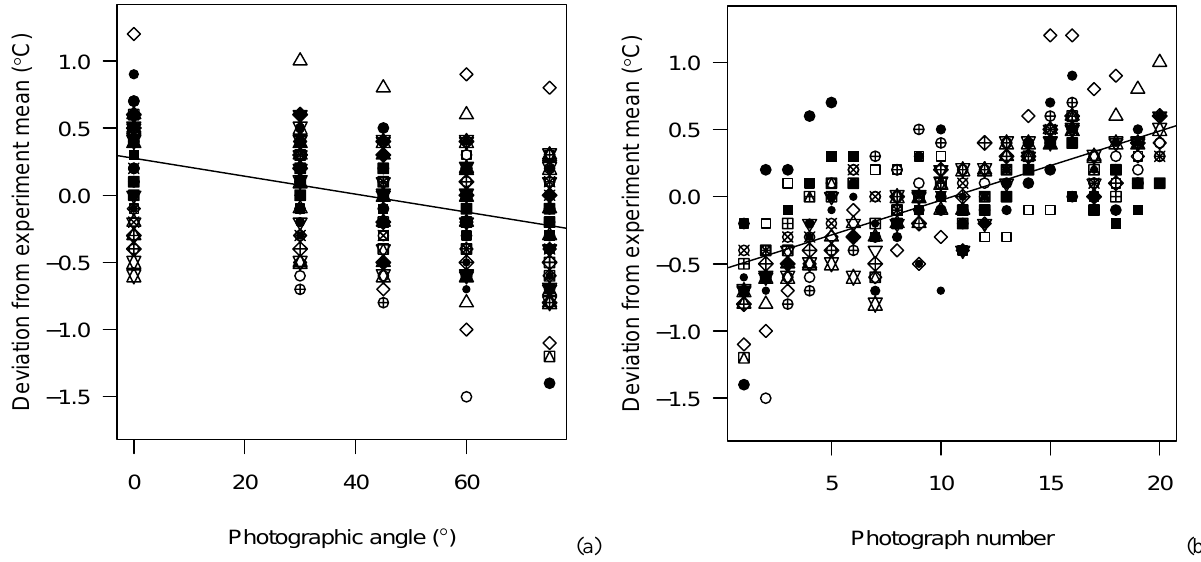
Fig. 4. (a) Relationship between apparent surface temperature and photographic angle, with fit linear model. (b) Relationship between surface temperature and order in which the thermograph was taken, with fit linear model. Both graphs display each experiment with distinct symbols, and the mean of each experiment has been re-centered to 0 ◦ C to show cross-experiment